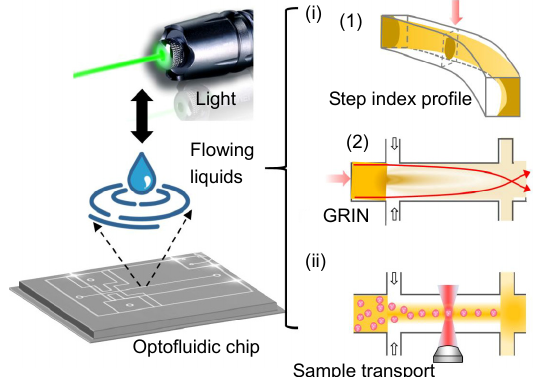
Fig. 1 | The principle of optofluidic chip and two kinds of inter- action between light and flowing liquids . (i) The interaction of light and pure liquids. (1) Liquids with a step index profile. (2) Liquids with a GRIN distribution. (ii) The interacion of light and biochemical sam- ples in flowing